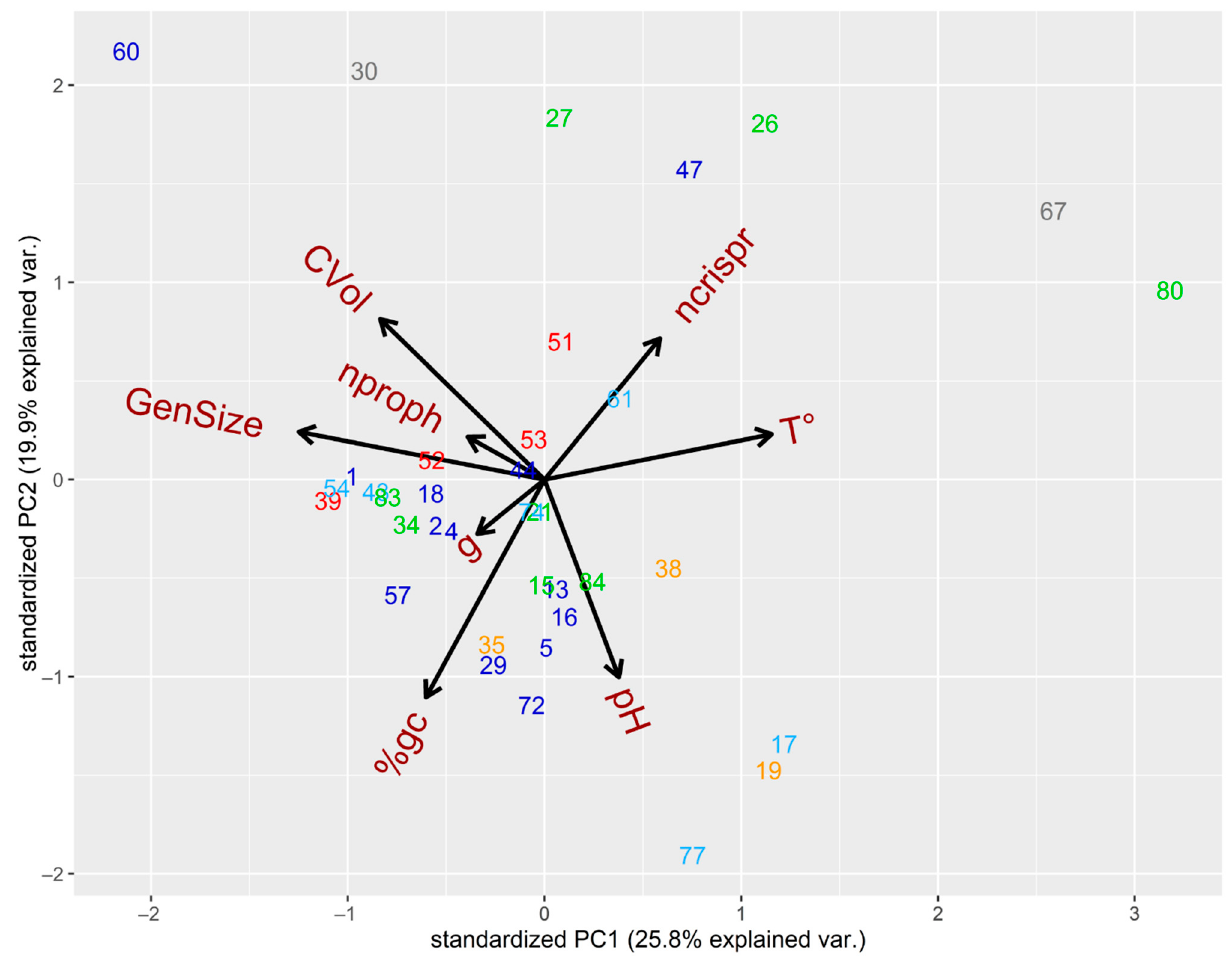
Figure 3. Principal component analysis of SRP according to their genomic and ecophysiological traits. Lysogenic SRP were compared based on the following eight metrics: number of prophages per cell (nproph), number of CRISPR (ncrispr), optimum pH for growth (pH), optimum temperature for growth (T°), GC content (% gc), minimum doubling time (g), cell volume (CVol), and genome size (GenSize). The numbers indicate de number of each SRP (according to Table S2), and color indicates their phylogenetic affiliation (according to Figure 1). Strains D. desulfuricans subsp. desulfuricans str. ATCC 27,774 and Desulfobulbus propionicus type strain 1pr3 were excluded of the analysis, since they have the highest and lowest values of cellular volume.